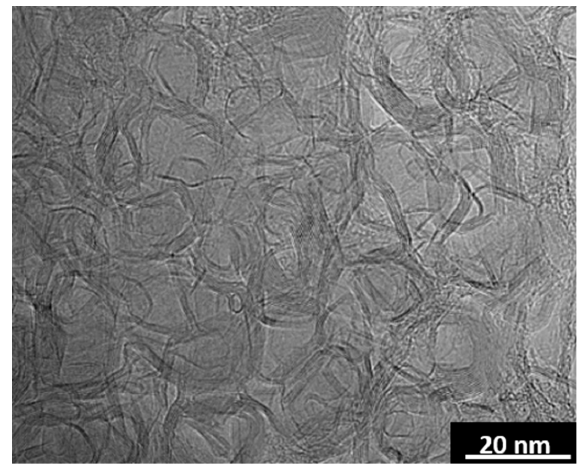
Figure 18. TEM micrograph of sucrose char after 30 s at 2600 °C.